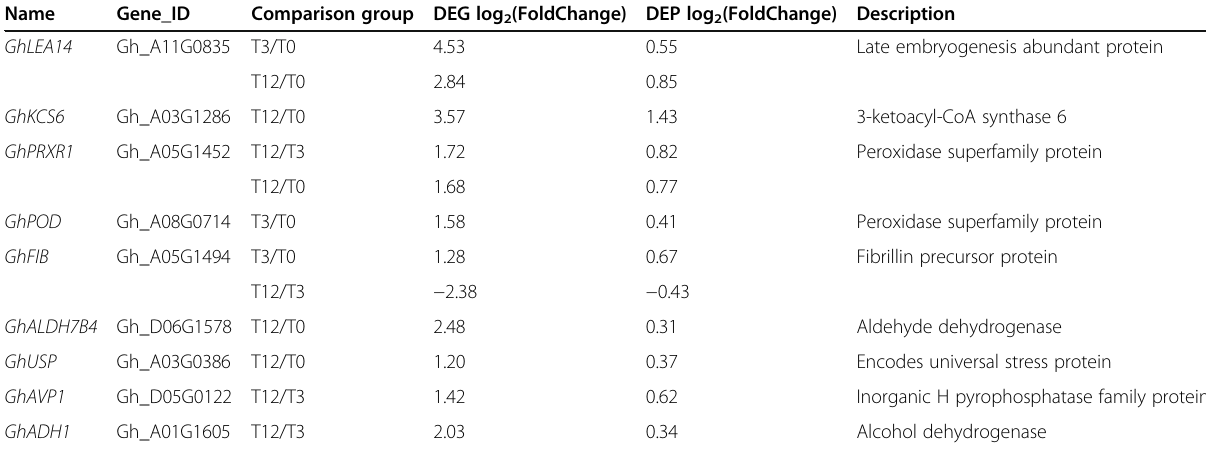
Table 1 Candidate genes involved in salt stress response in